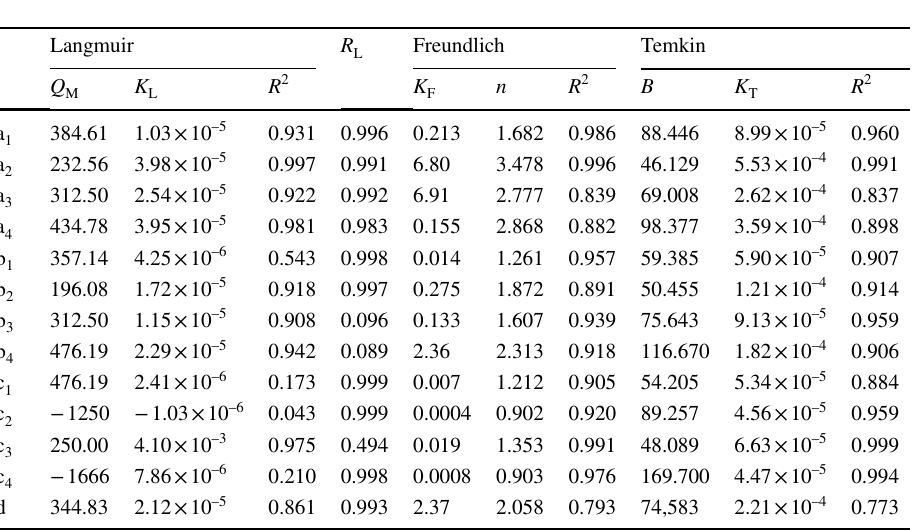
Table 2 Adsorption